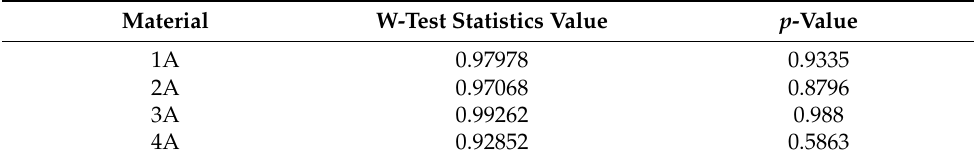
Table 4. S-W test results for individual materials.